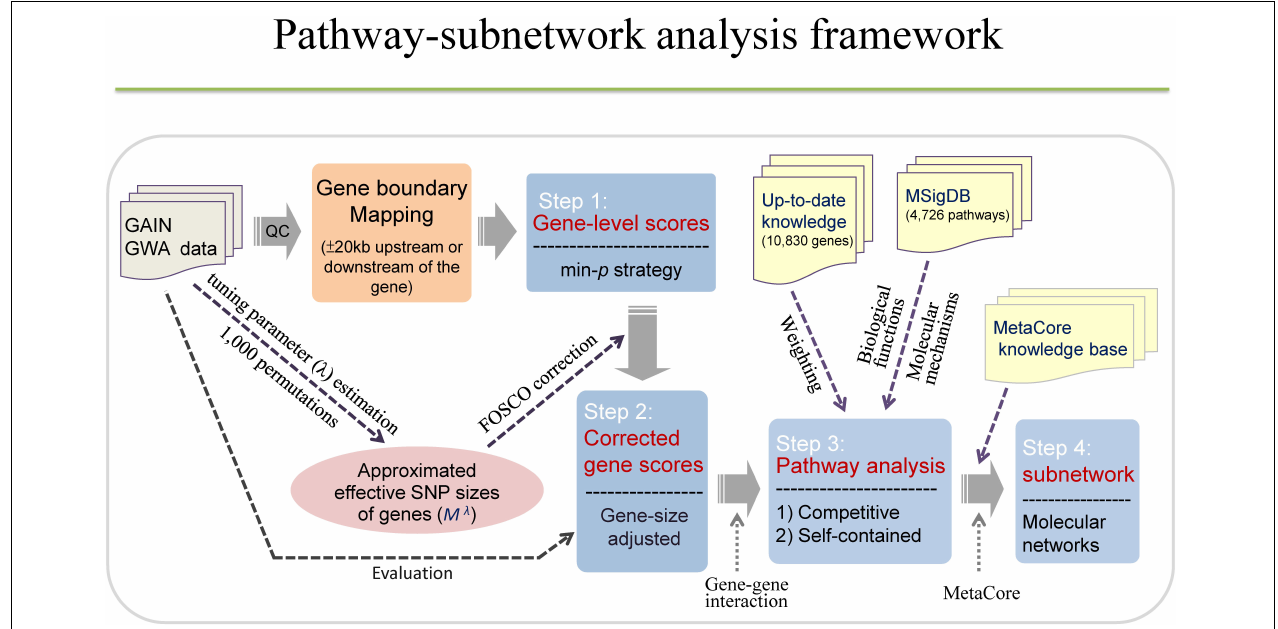
FIGURE 1 | The study framework. The study consists of four steps, including calculation of gene-level scores, gene scores corrections, pathway analysis, and subnetwork analysis. Each gene was assigned a gene-level score using minimal p -value of association test among SNPs in a gene. Corrected gene scores can be obtained by calculating gene-size adjusted p -values based on FOSCO correction. Pathway analysis was conducted using competitive method (hypergeometric test, GSEA) and self-contained method (sum-statistic) with and without weighting scheme. Subnetwork analysis was performed to construct molecular networks using